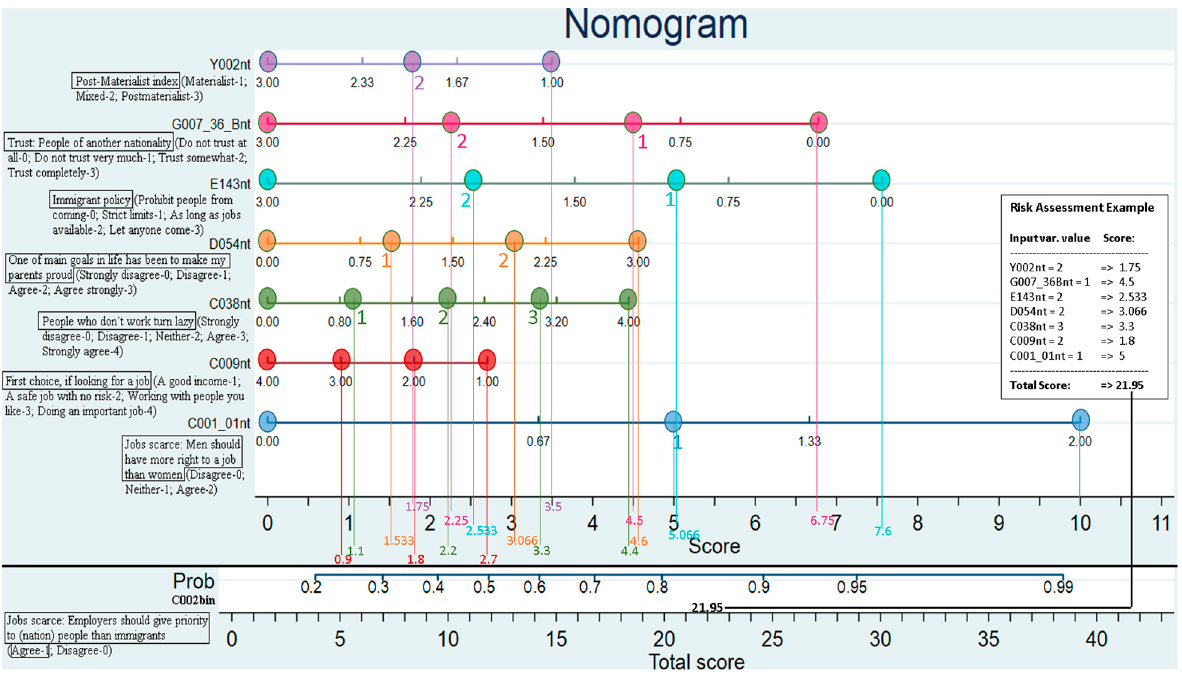
Figure 2. Assessing collinearity using consecutive matrices with correlation coefficients only for predictors (Stata script at https://tinyurl.com/ueefxfmd, accessed on 30 January 2023).